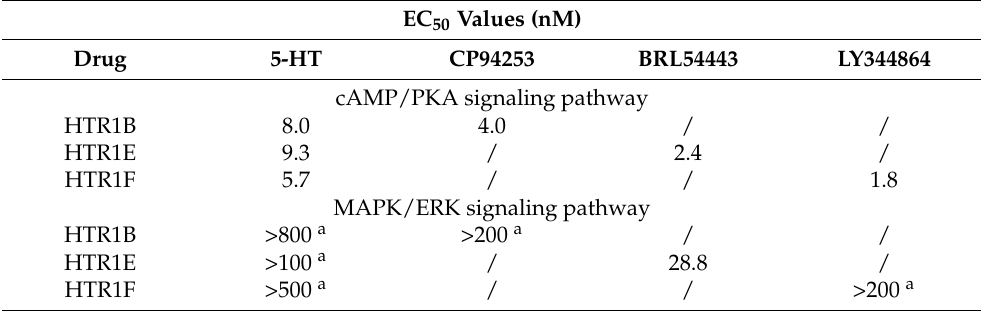
Table 1. EC 50 values of 5-HT, CP94253, BRL54443 and LY344864 in activating different signaling pathways in HEK293 cells expressing chicken HTR1B, HTR1E or HTR1F.